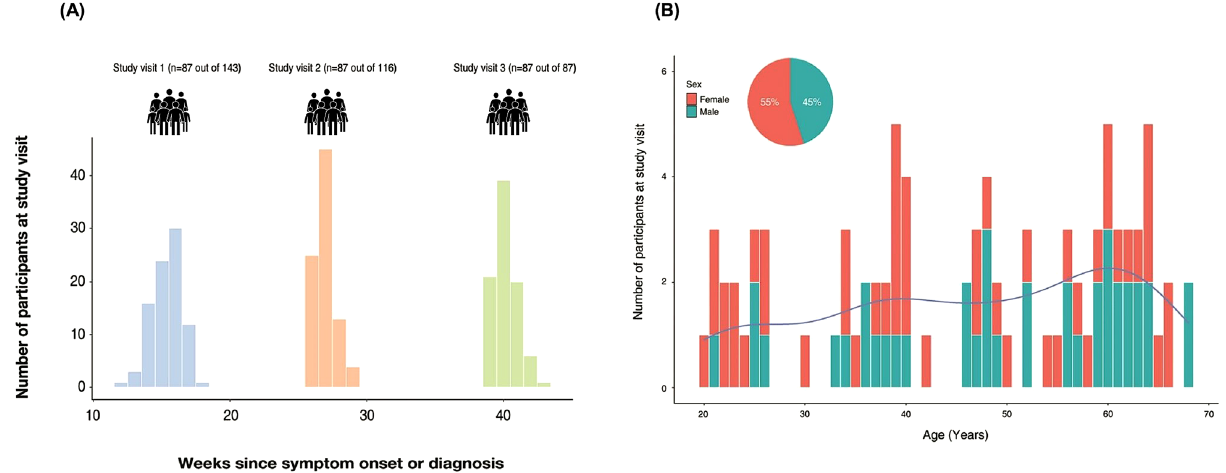
Figure 1. Study design and characteristics of study participants. ( a ) Study timeline and number of participants at each study visit. The graph represents blood sample collection time for participants from symptom onset or COVID-19 diagnosis ( b ) Participants’ age and sex